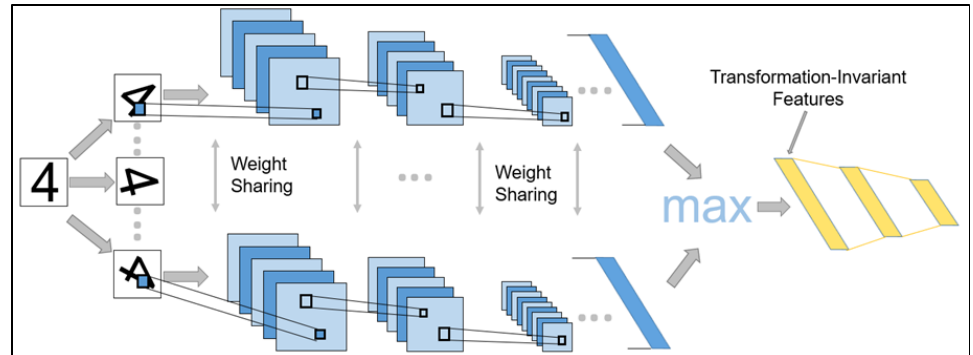
Figure 4. TI-POOLING CNN architecture.